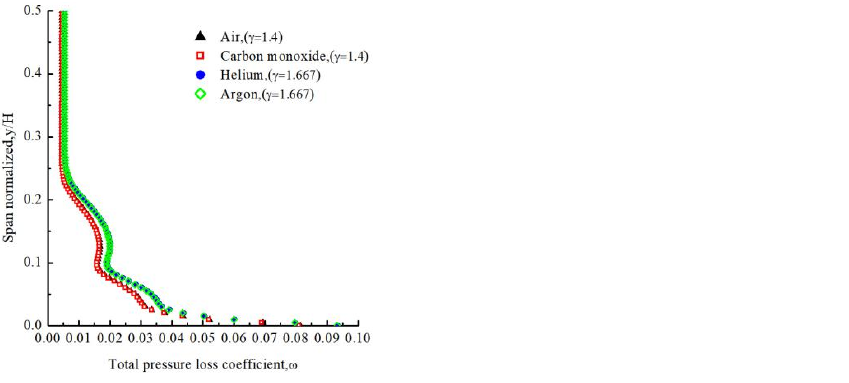
Figure 4. Distribution of coefficient of total pressure loss with different working fluids.